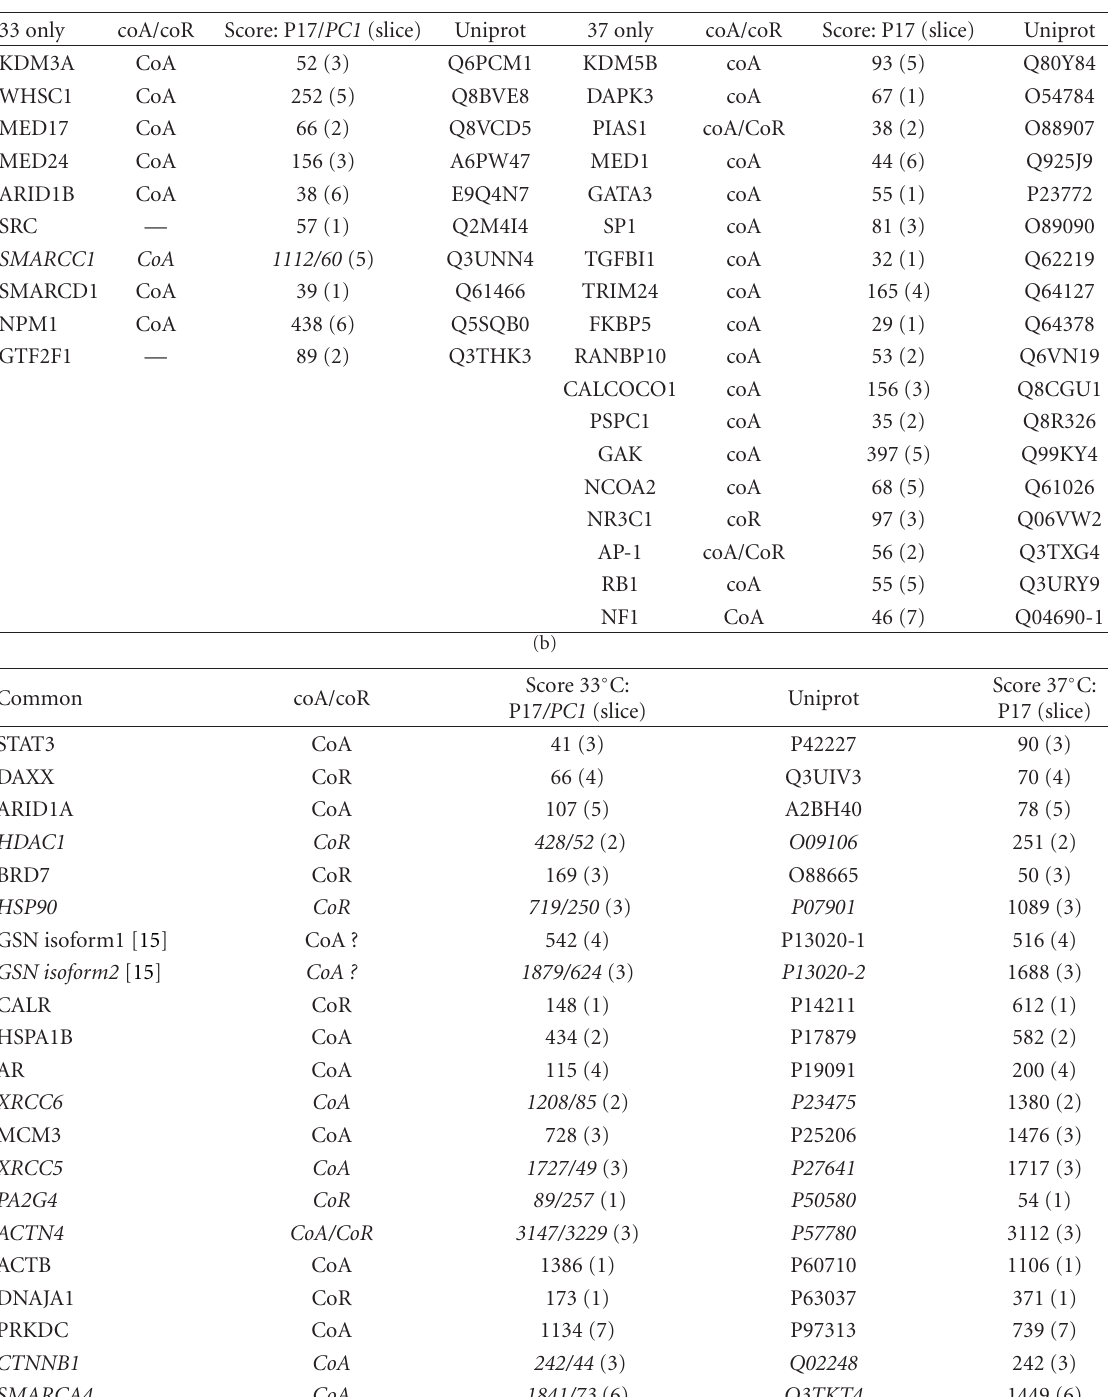
Table 1: List of only the known androgen-receptor-interacting proteins and coregulators (http://androgendb.mcgill.ca) identified after mass spec analysis of all gel fractions (Figure 3(a)) from FLAG purifications of nuclear extracts from P17 cells grown under proliferating and nonproliferating conditions (see Section 2). (a) Listed are the interacting proteins that were unique for the proliferating cells (33 only), interacting proteins that were unique for the nonproliferating cells (37 only), and (b) interacting proteins common to both (common). The AR is highlighted. Given are the Uniprot accession numbers identified by the database Mascot search (Uniprot), the score achieved in the peptide summary report (score), the gel slice number (), and information whether the protein had been identified as a coactivator (CoA), corepressor (coR), or the e ff ect has not been reported (—). Activating function has been allocated to GSN [13, 14], without distinguishing between the 2 isoforms